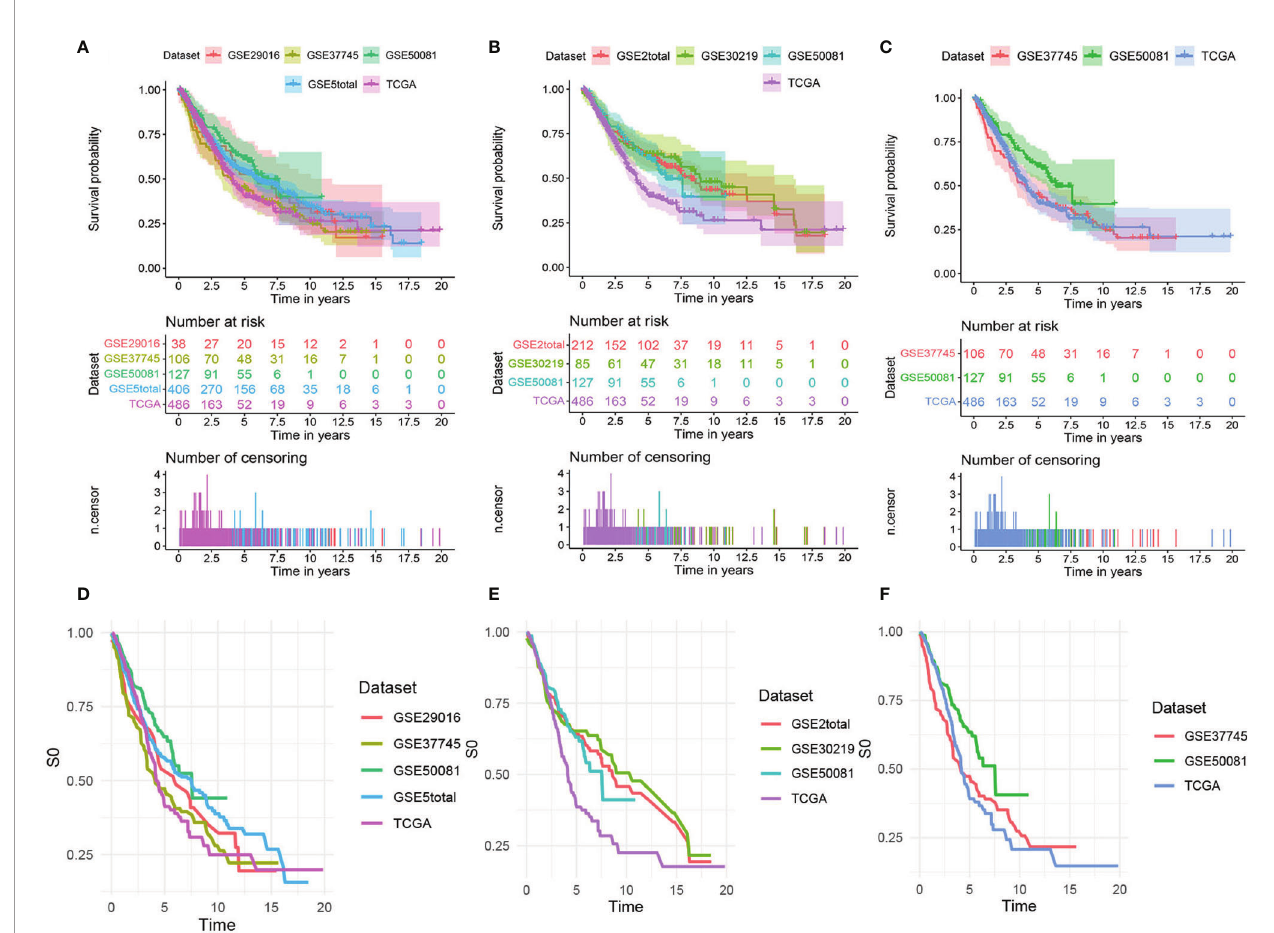
FIGURE 2 | The survival curves and baseline survival probability curves of each data set in the three models. The survival curves of each data set in (A) the mRNA model, (B) the lncRNA model, and (C) the comprehensive clinical model. The baseline survival probability curves of each data set in (D) the mRNA model, (E) the lncRNA model, and (F) the comprehensive clinical